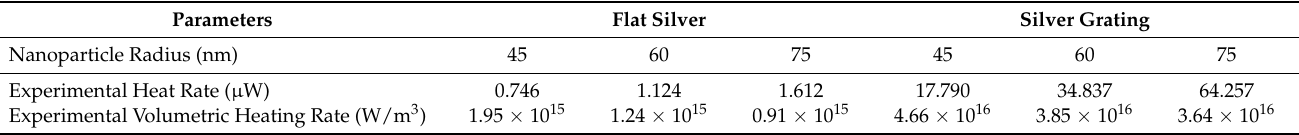
Table 1. Experimental result for nanoparticle embedded in flat silver and silver